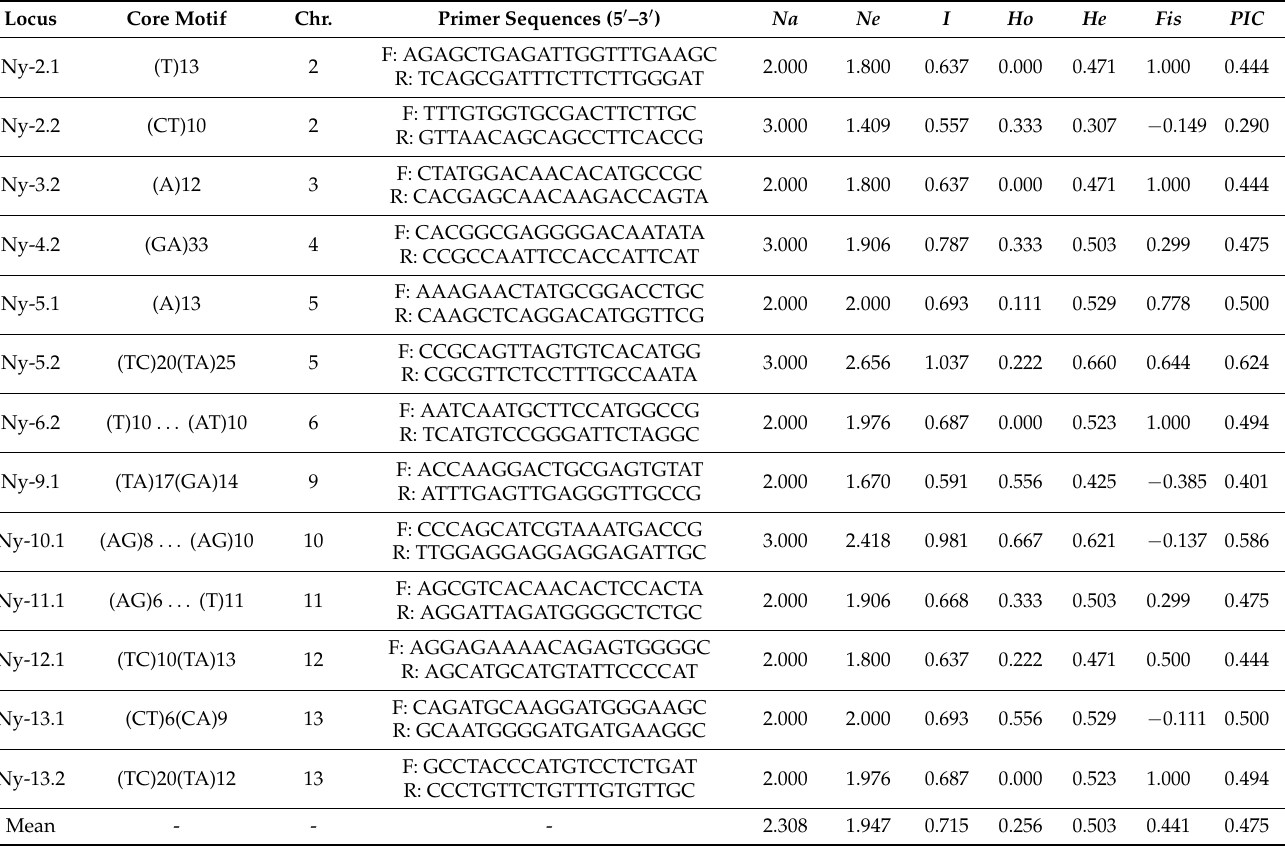
Table 1. Characteristics of the 13 polymorphic microsatellite loci and primer sets.